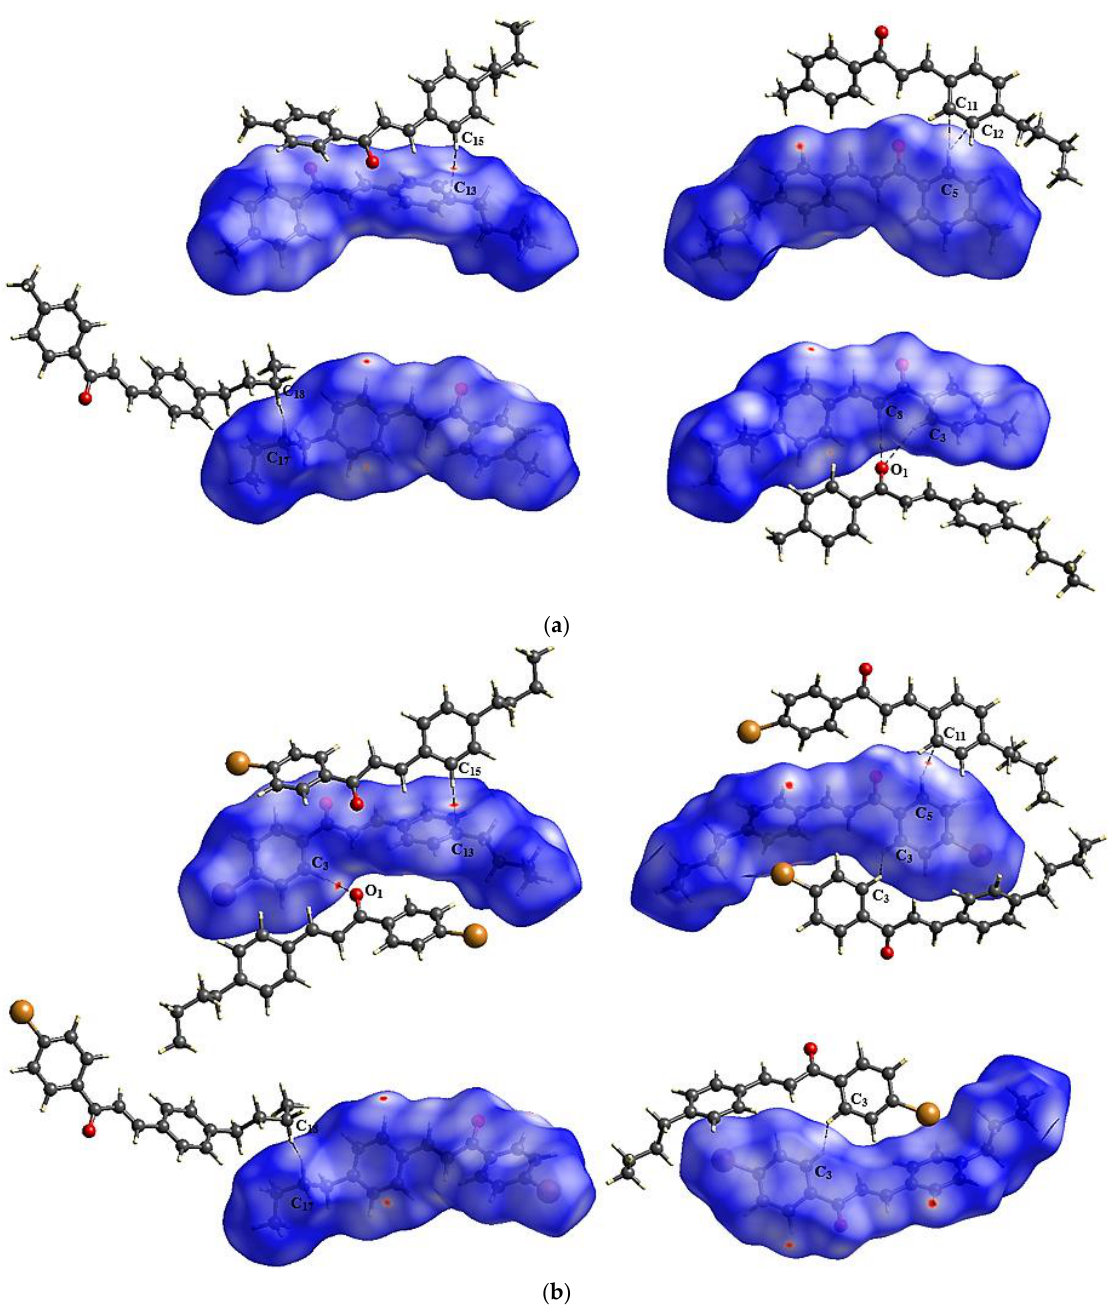
Figure 9. The Hirshfeld surface 𝑑 𝑛𝑜𝑟𝑚 map showing the interactions observed in the molecular packing of ( a ) BMP and ( b ) BBP chalcones.